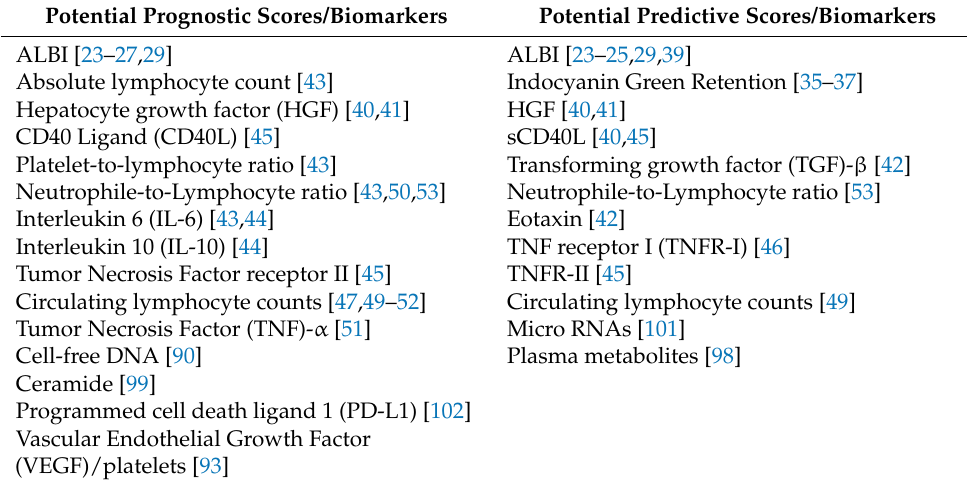
Table 3. Potential prognostic and predictive scores and biomarkers for patients undergoing radio- therapy for liver